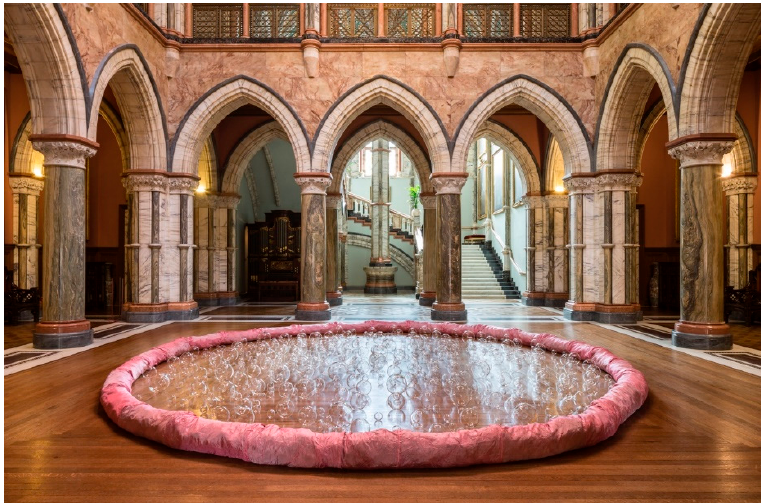
Figure 7. Christine Borland, “to The Power of Twelve”, 2018. 444 hand blown clear glass spheres, section of silk army surplus parachute stuffed with dried sphagnum moss. Image Courtesy of Christine Borland.